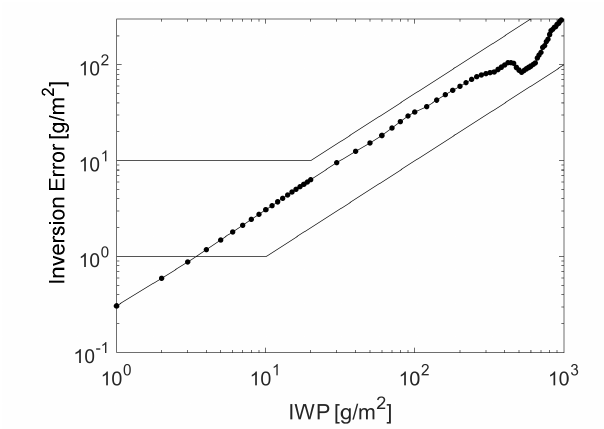
Figure 8. The inversion error of multi-channel regression method for di ff erent values of ice water path. The solid black lines depict the scientific mission requirements, which denote a 1–10 g / m 2 requirement range for low IWP and a 10–50% relative requirement range for high IWP,